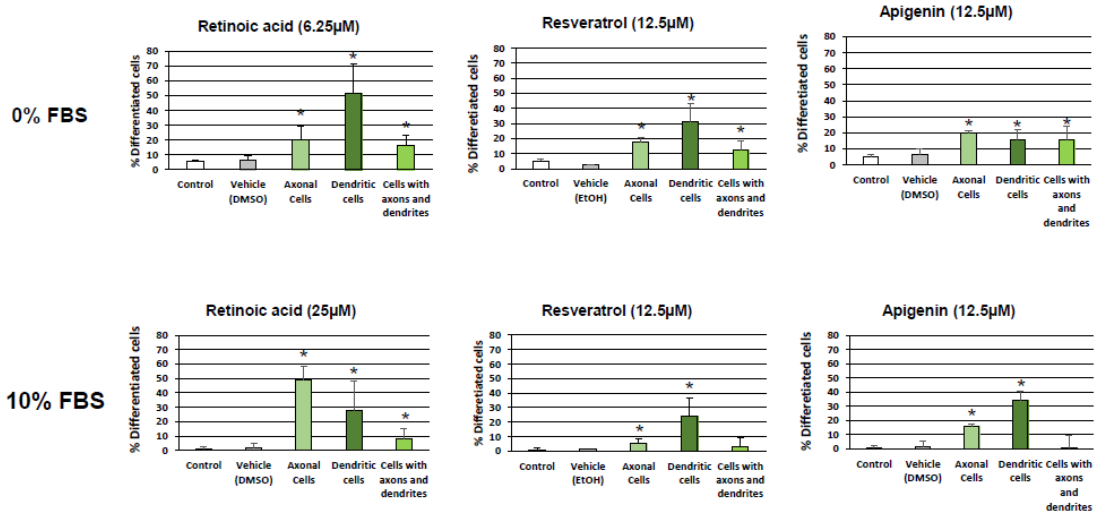
Figure 4. Characterization and quantification of differentiated neuronal cells (cells with dendrites, axons and dendrites + axons) induced by resveratrol and apigenin. Murine neuronal N2a cells previously cultured for 24 h in conventional cultured medium were further cultured for 48 h in medium without and with 10% FBS in the absence or in the presence of retinoic acid (RA: 6.25 µM with 0% FBS; 25 µM with 10% FBS) used as positive control for the induction of neuronal differentiation, or with polyphenols: resveratrol (RSV: 12.5 µM with 0% and 10% FBS) and apigenin (API: 12.5 µM with 0% and 10% FBS). Control cells were cultured in medium without and with 10% FBS. Two vehicle controls were realized: EtOH used with RSV, and DMSO used with RA and API. The percentages of cells with dendrites, axons, and axons + dendrites are shown, and were determined by phase contrast microscopy. Each value is the mean ± standard deviation (SD) of four independent experiments. An ANOVA test followed by a Mann–Whitney test were used. p values of 0.05 or less were considered as statistically significant. * comparison between control (untreated cells), vehicles (DMSO, EtOH), and RSV, API, and RA; no difference between control/vehicles (DMSO, EtOH) was